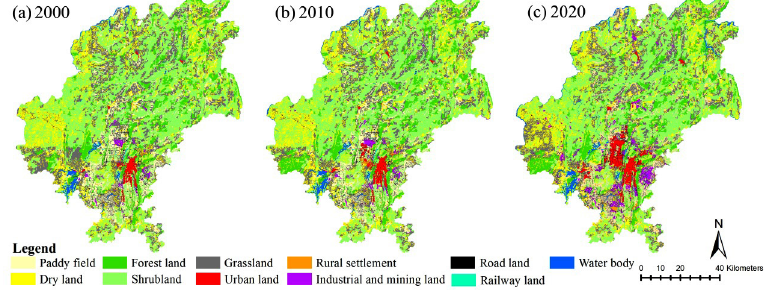
Figure 2. Spatial map of land use types in